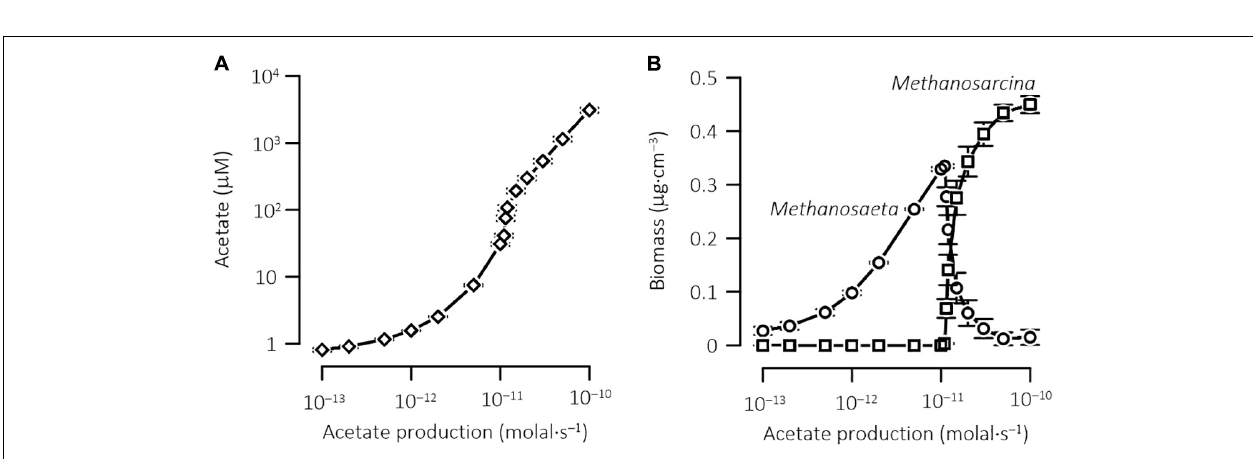
FIGURE 8 | Results at steady state of the reactive transport model, showing the variations in the concentrations of acetate (A) and biomass (B) with the rates of acetate production in the sediments. Data points are the means over the sediment depth; error bars show standard error of the